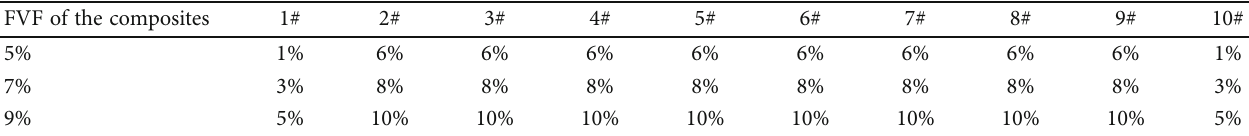
Figure 4: Elastic modulus investigation with respect to axial length ratio of the ellipsoid inclusion. Table 2: FVF in each